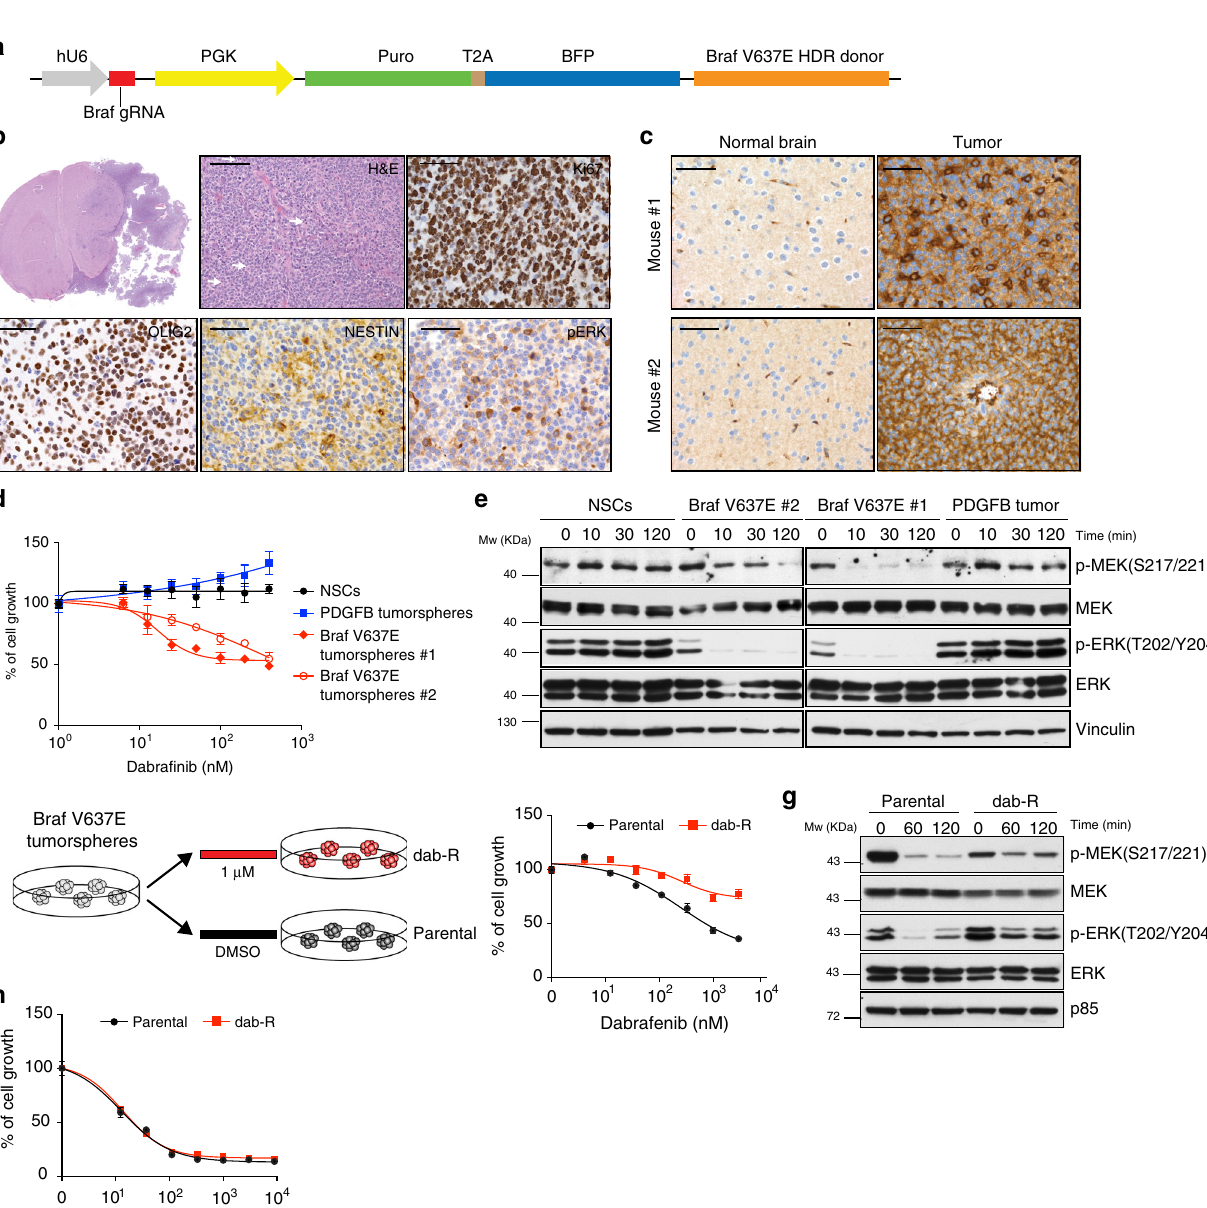
have evidenced the emergence of drug resistance after marked initial responses 45,46 . Genetic pro fi ling of the tumors and xenopatient samples displayed acquisition of point mutations in the catalytic domain of NTRK1 (p.G595R and p.G667C) and NTRK3 (G623R) 45,46 .